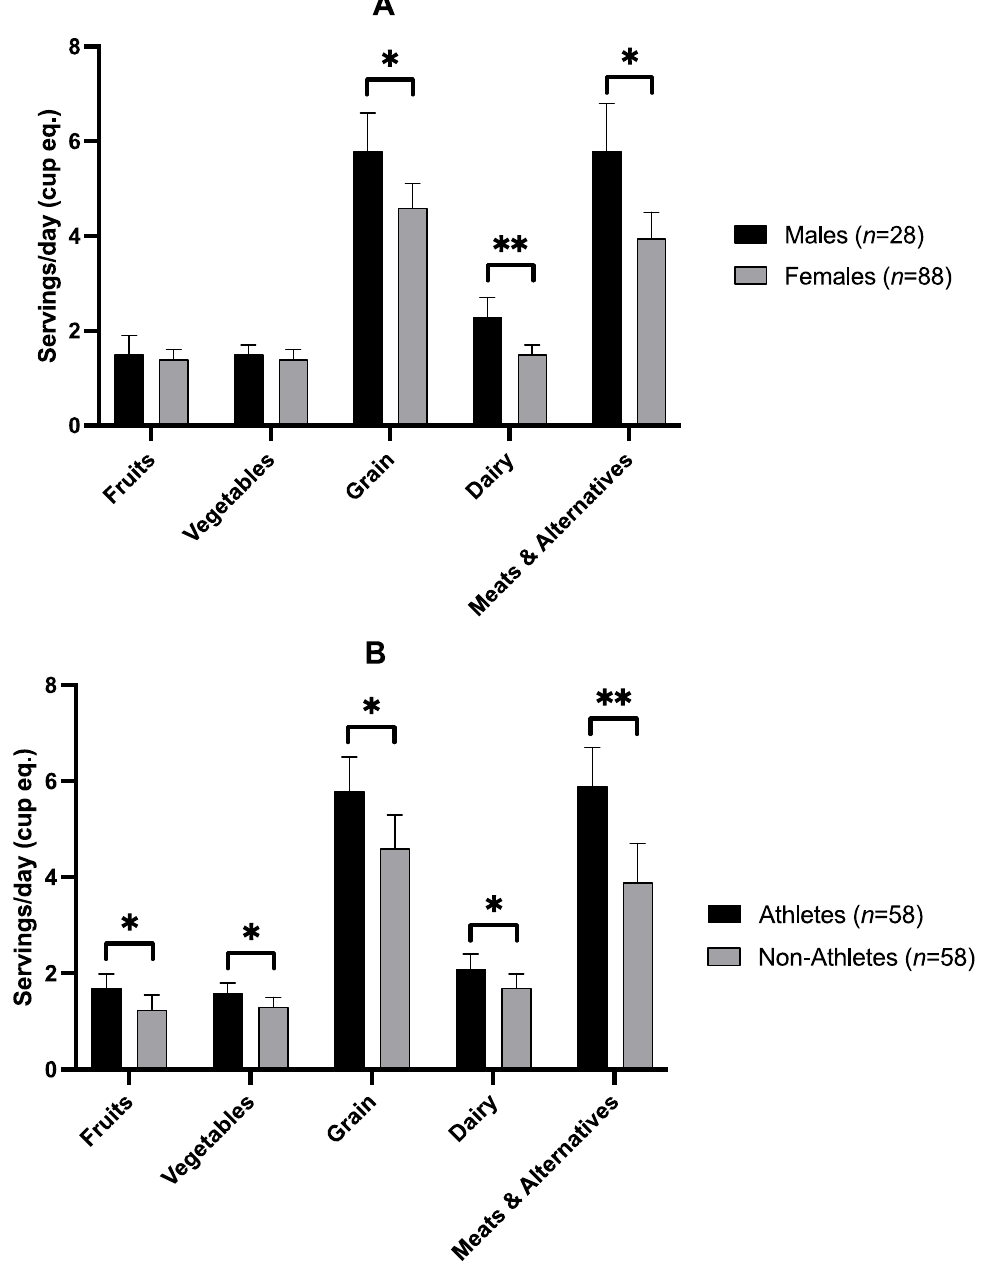
Figure 2. Servings per day for fruits, vegetables, grains, dairy, meat, and alternatives in males versus females ( A ), and athletes versus nonathletes ( B ). Values are means ± SD. * denotes p < 0.05 difference between sexes ( p = 0.05); ** denotes p < 0.001 difference between sexes. (kcal/kg/day) terms. There was no sex-by-group interaction in either absolute or relative between athletes and nonathletes for both absolute (517 kcal difference, F = 16.4, p <